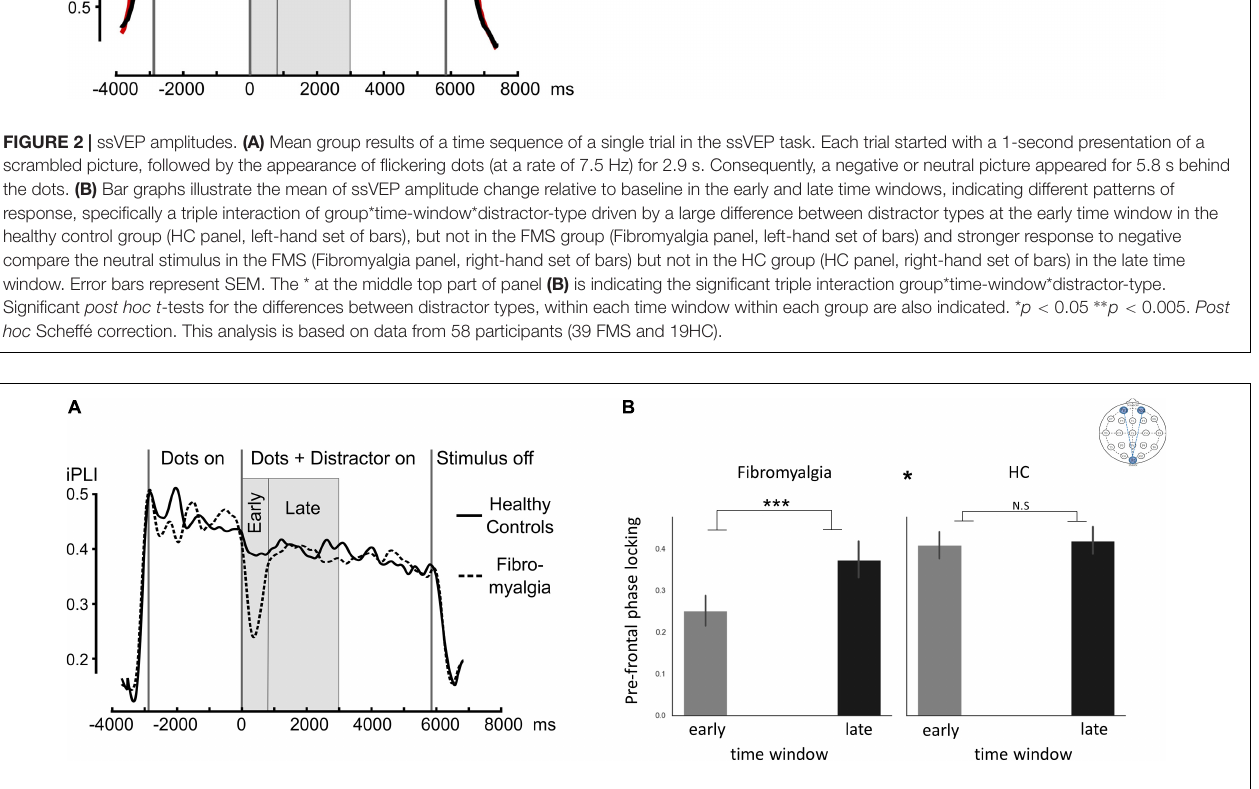
FIGURE 3 | ssVEP connectivity. “Fronto-occipital connectivity,” indicating Oz phase-locking indices with frontal electrodes (Fp1 and Fp2). (A) Mean inter-site phase-locking index (iPLI) time sequence during a single trial in the ssVEP task across all distractor types. (B) Bar graphs describing the mean phase-locking index across distractor types in early and late time windows. The * at the middle top part of panel (B) is indicating the significant group*time window interaction. Significant post hoc t -tests for the differences between time windows within each group. Error bars represent SEM. * p < 0.05, *** p < 0.0005. Post hoc Scheffé correction. This analysis is based on data from 58 participants (39 FMS and